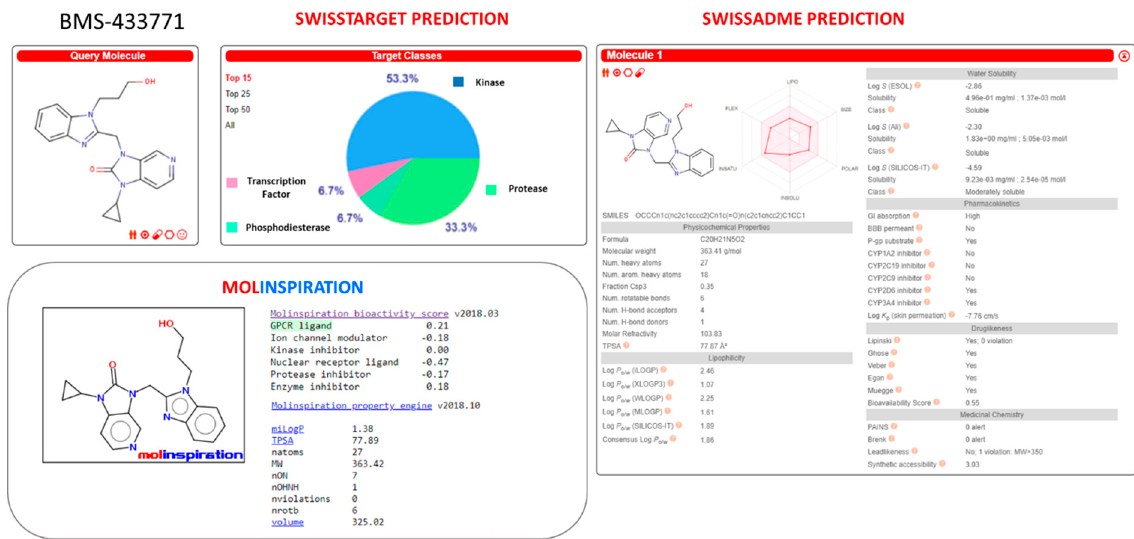
Figure 20. Prediction of ADME properties as well as of putative off-targets preferences featured by RV521. The reported in silico evaluation was performed thanks to SwissTarget website [42,43] and to the Molinspiration Property Calculation Service [44].